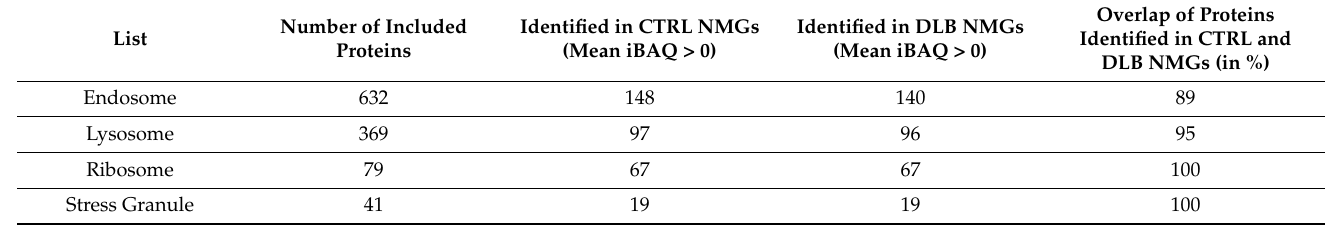
Table 4. Summary of identified proteins for endosomes, lysosomes, ribosomes and stress granules in NMGs of CTRL and DLB